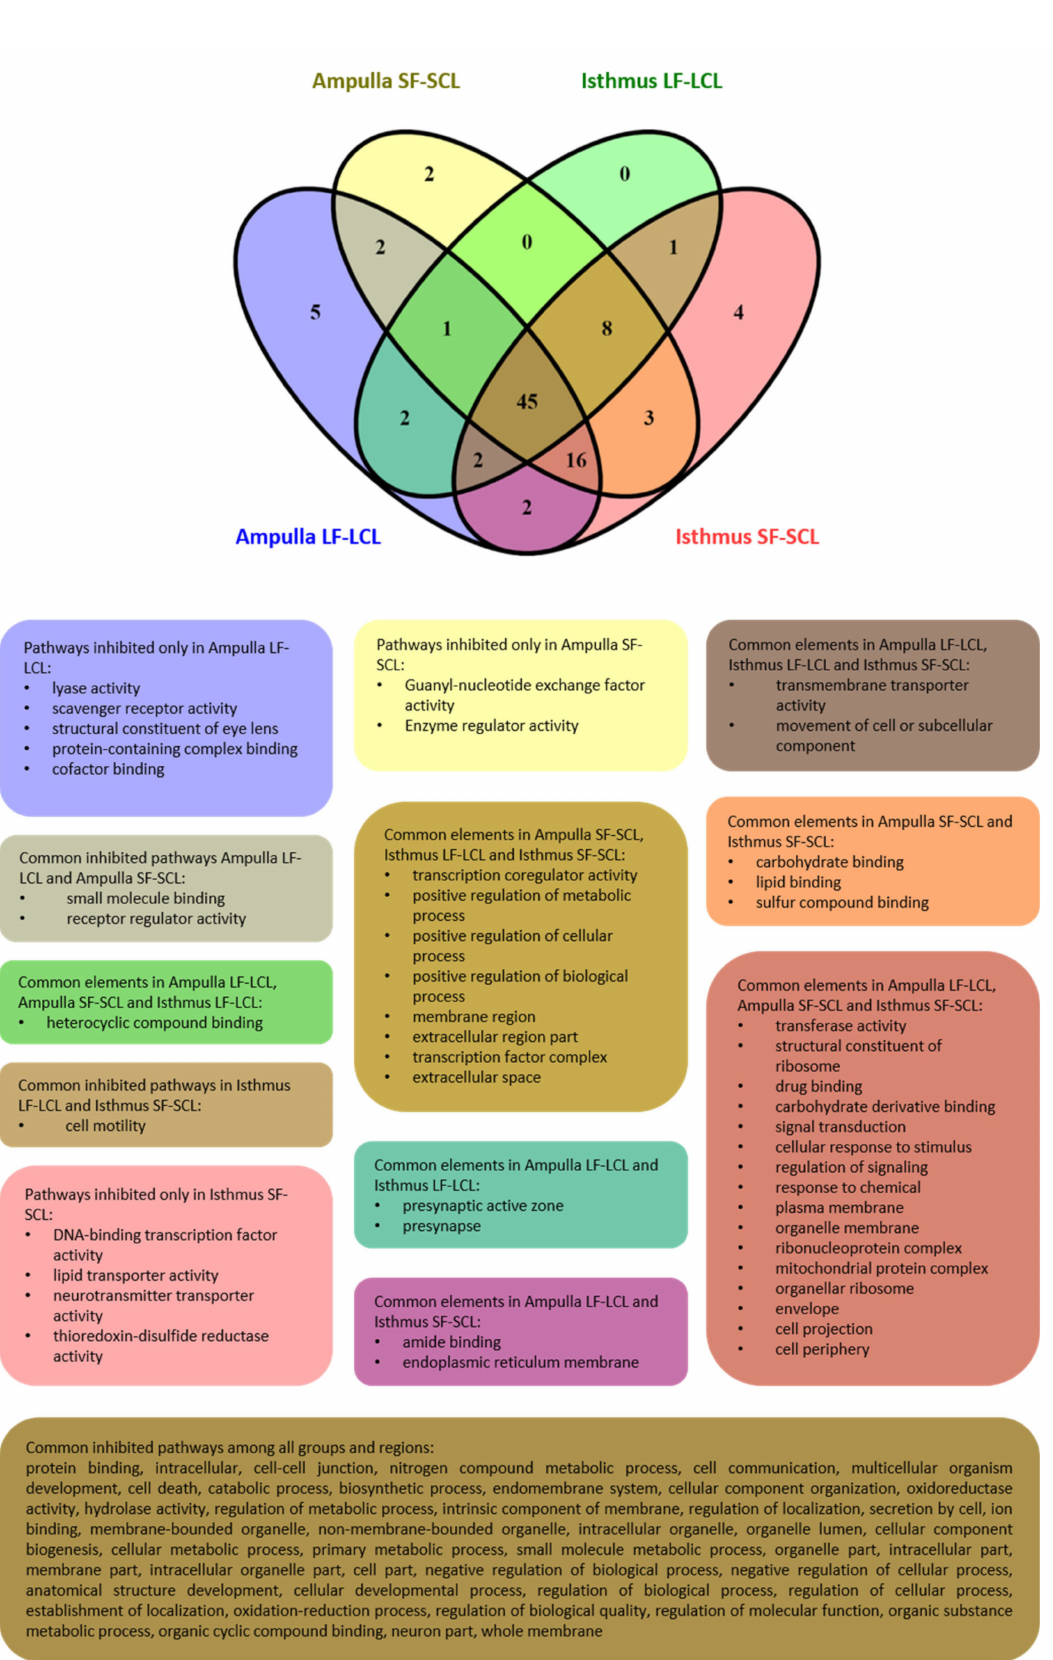
Figure 7. Venn diagram of the pathways modulated by miRNA-mRNA interactions. Venn diagram depicting differentially inhibited gene ontology pathways in the ampulla and isthmus of the LF-LCL and SF-SCL